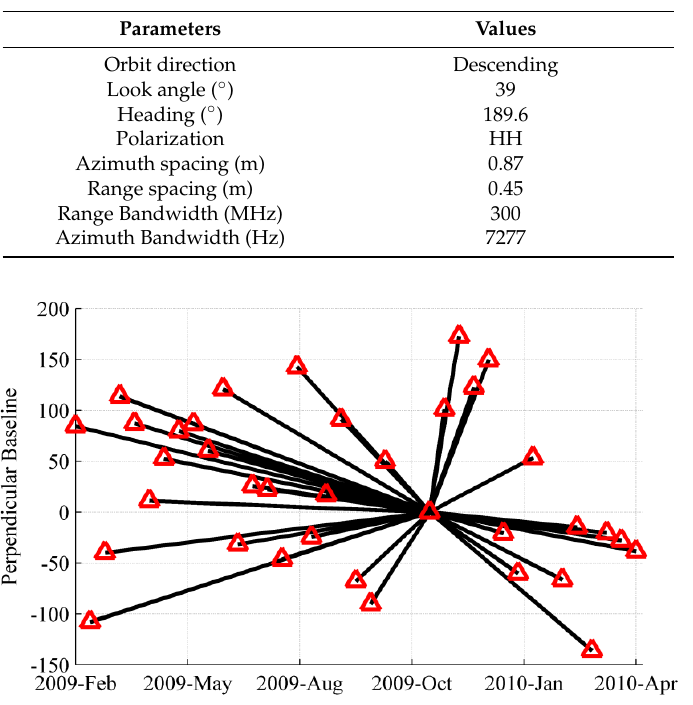
Table 1. Basic information for high resolution spotlight TerraSAR-X datasets.